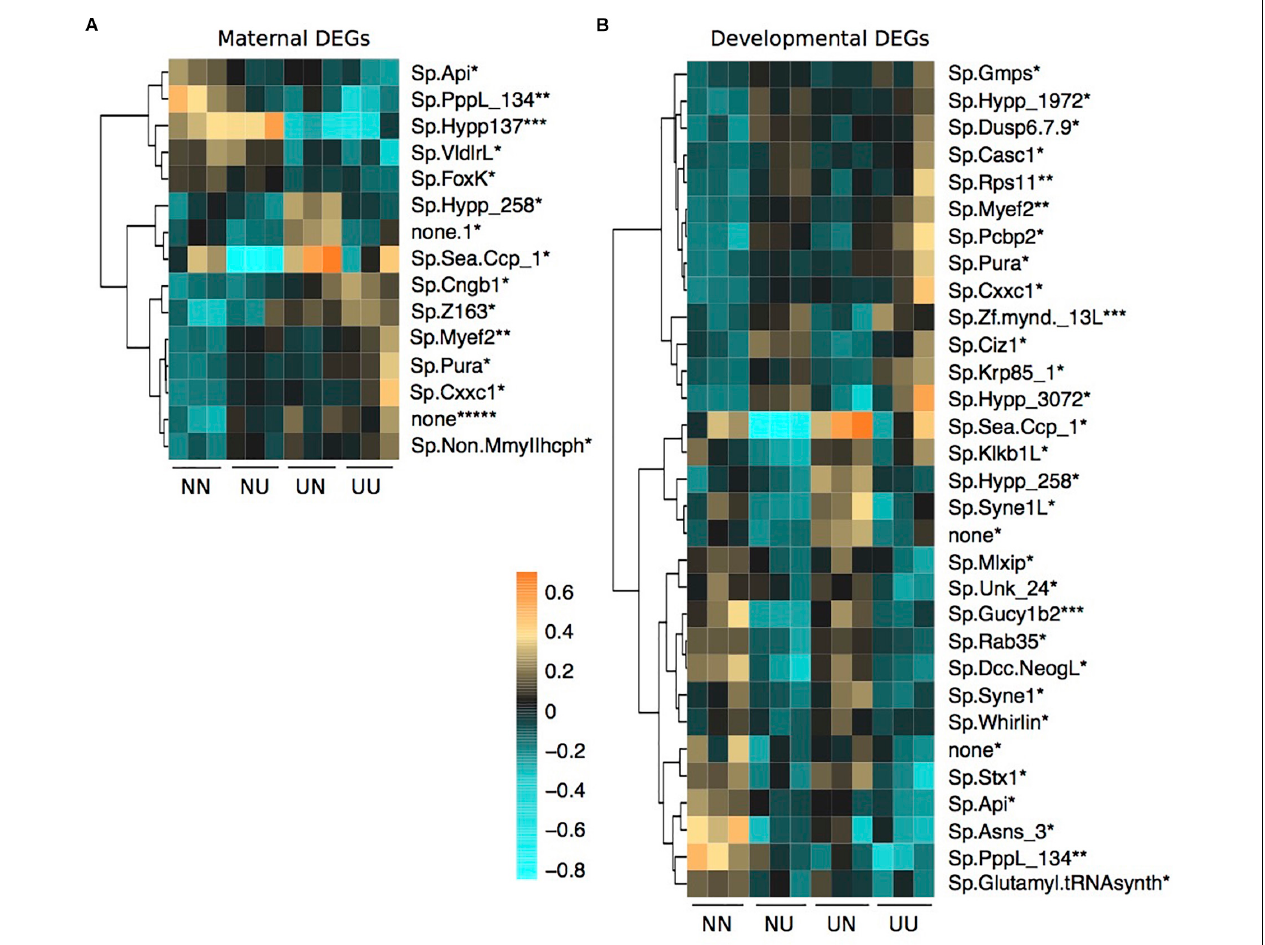
FIGURE 5 | Differentially expressed genes by maternal environment (A) and developmental environment (B) containing differentially methylated CpGs. Asterisks by each gene name denote the number of DMCpGs within that gene region. Scale is log2fold change relative to the gene